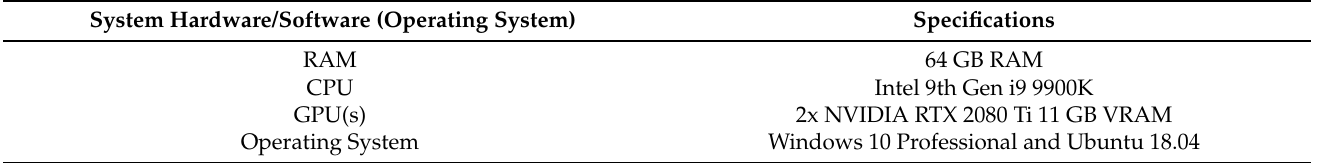
Table 3. System Specifications for Training/Testing.